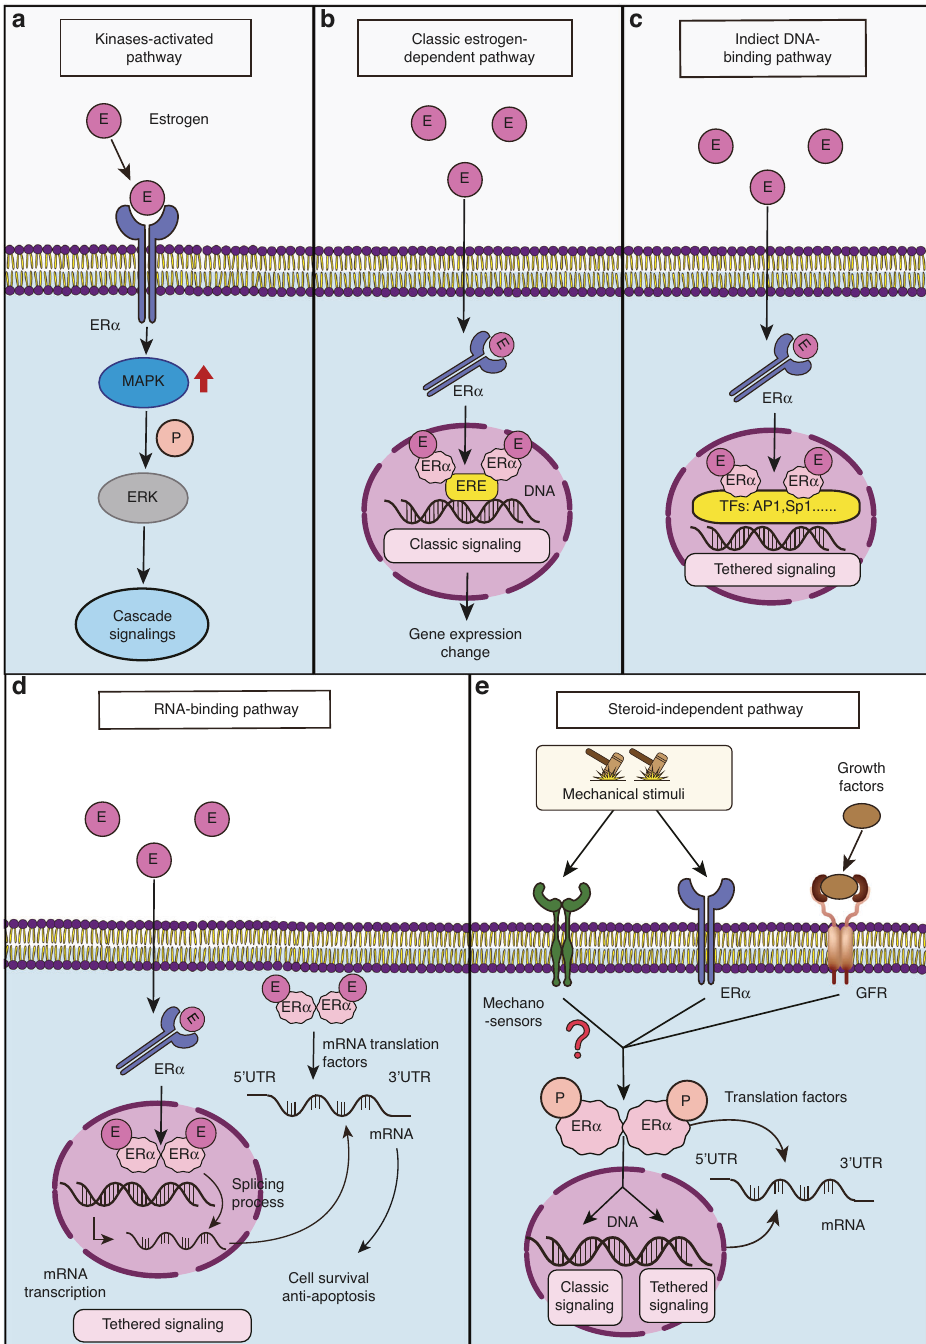
Fig. 4 Known functions of ER α . a – d Ligand-dependent regulatory pathways . ER α binds with ligands such as E2, which can ( a ) directly activate MAPK signaling, b bind with DNA to function as a transcription factor (classic signaling factor), c bind with other transcription factors to in fl uence gene expression (tethered signaling), and d modulate mRNA splicing or translational processes by binding to mRNA. e Steroid- independent regulatory pathways. ER α can be activated by mechanical load or several growth factors, E: estrogen, ER α : estrogen receptor α , MAPK: mitogen-activated protein kinase, ERK: extracellular signal-regulated kinase, P: phosphorylation, ERE: estrogen response element, TF: transcription factor, AP1: activating protein-1, Sp1: speci fi city protein 1, and GFR: growth factor